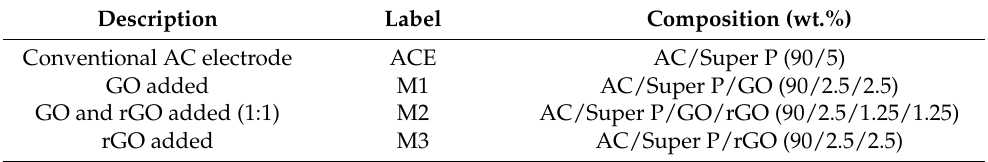
Table 1. Comparison of electrode configurations.